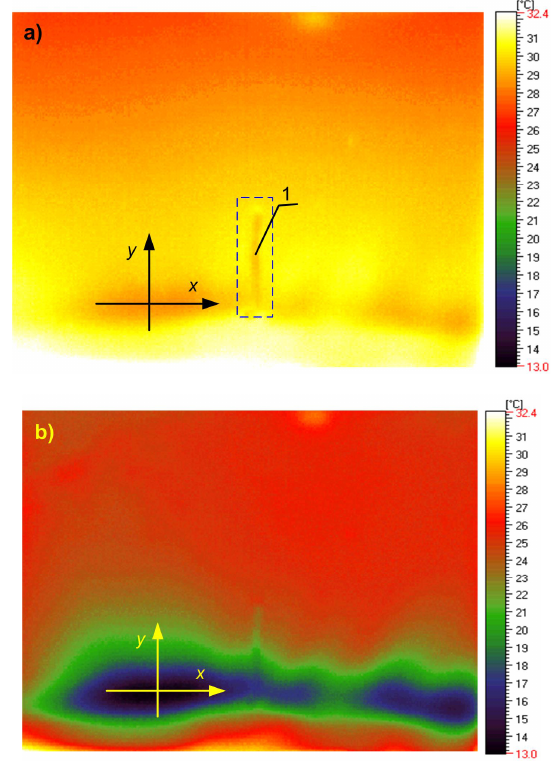
Fig.2. Thermograms of a windscreen respectively 4 and 18 minutes after switching on the cooling system, 1- calibration